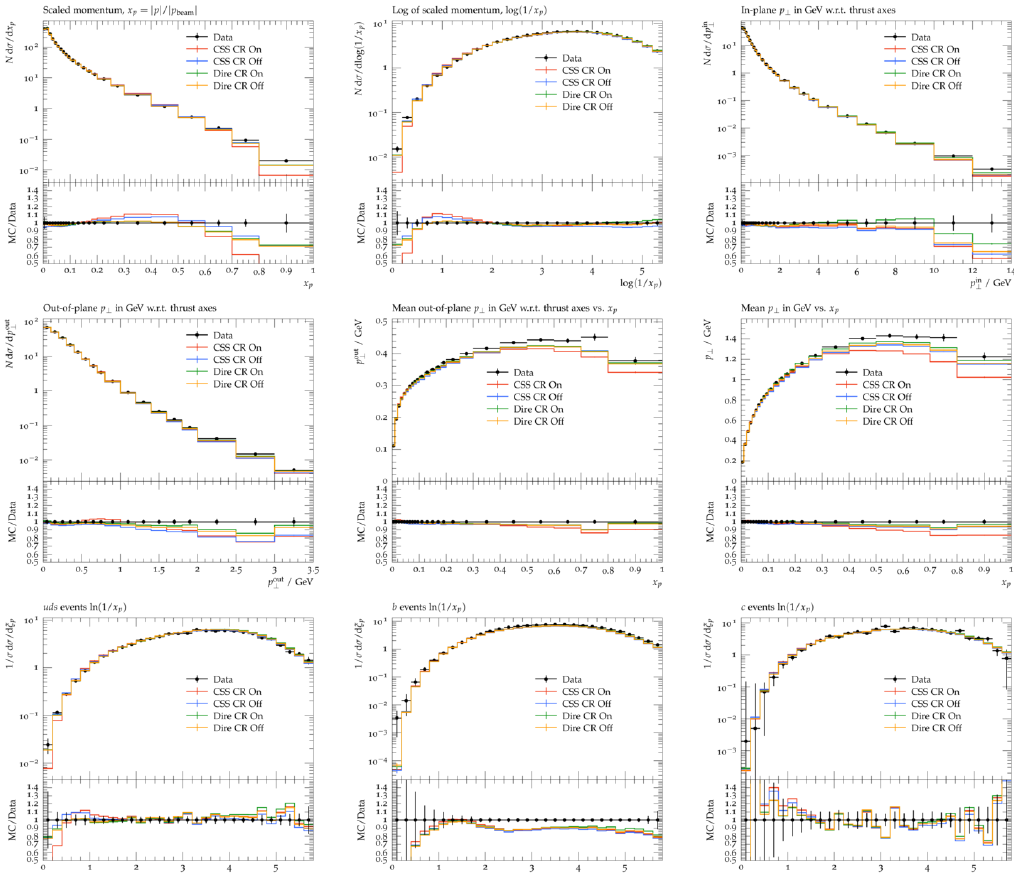
Figure 4: Longitudinal momenta fractions x (upper left) and log1 / x (upper mid- p p dle), transverse momenta in-plane (upper right) and out-of-plane (centre left), with respect to the thrust axis, and the mean value of the out-of-plane and total transverse momenta as a function of x (centre middle and right). The S HERPA results are com- p pared with data from D ELPHI [ 47 ] . Measurement of scaled momentum distributions, ln1 / x , for uds quarks (bottom left), b quarks (bottom middle) and c quarks are p compared with data from O PAL [ 48